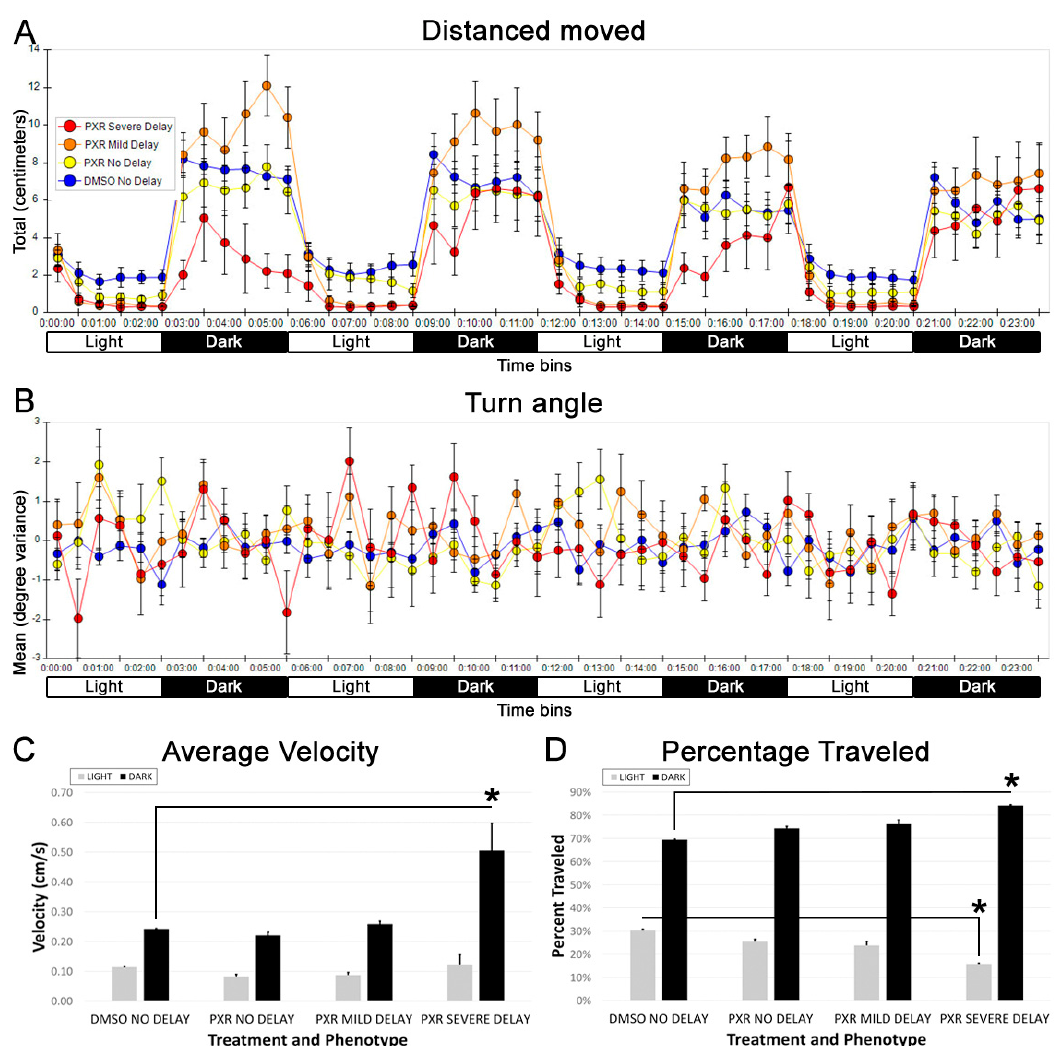
Figure 4. Abnormal movements observed in zebrafish at 7 dpf that were severely delayed by propoxur treatment at 40 hpf. ( A ) Graphical representation of the distance moved into 30-second bins: severely delayed fish (red circles) displayed extreme light aversion and a delayed response to movement in the dark. ( B ) Graphical representation of the turn angle into 30-second bins: severely delayed fish (red circles) displayed extreme changes in turn angle. ( C ) Graphical representation of the average velocity of movement in light and dark. ( D ) Graphical representation of the average percentage traveled in light and dark: asterisk represents statistical differences compared with group indicated in the graph ( p < 0.01).